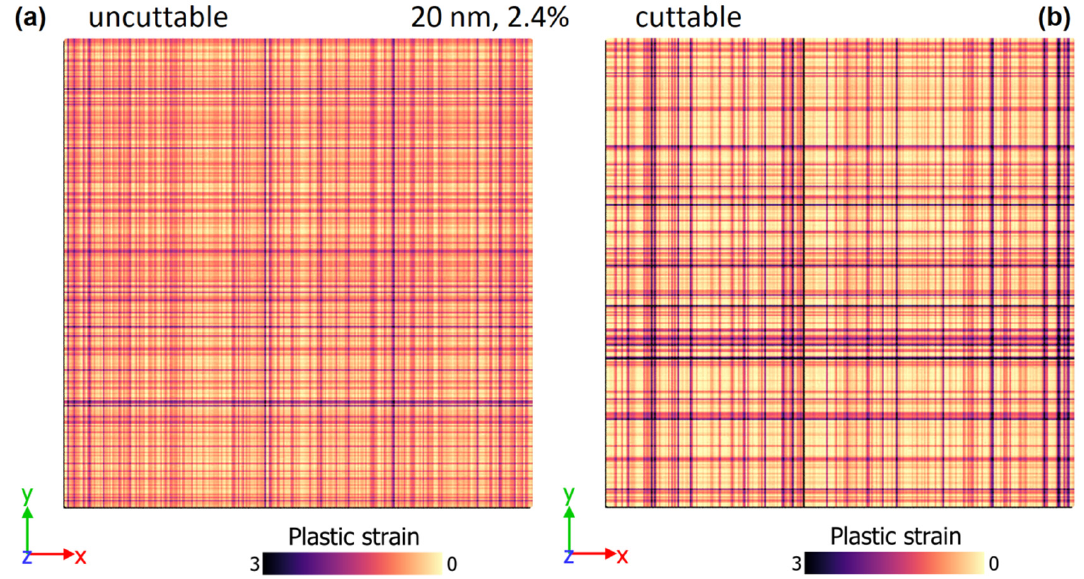
Figure 12. Localization of plastic deformation in system in cases of ( a ) “uncuttable” and ( b ) “cuttable” precipitates.